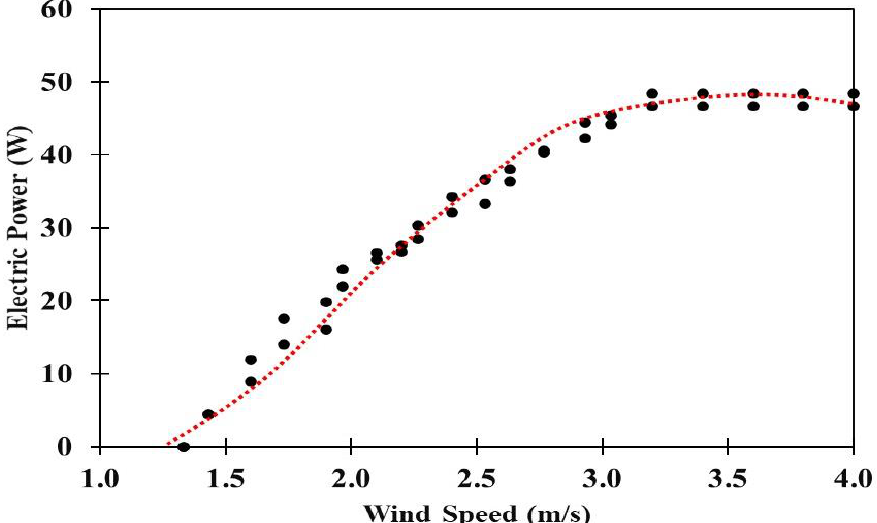
Figure 12. Vertical wind turbine behavior showing the relationship between electric power and rotational speed.